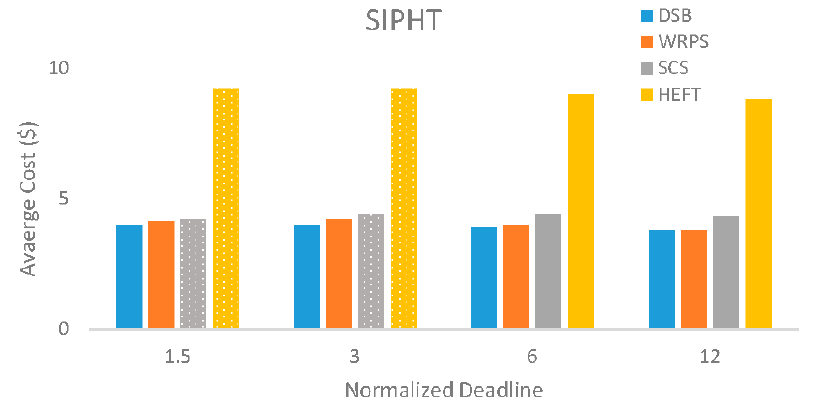
Figure 6. Average cost of LIGO Inspiral Analysis under varied normalized deadline.